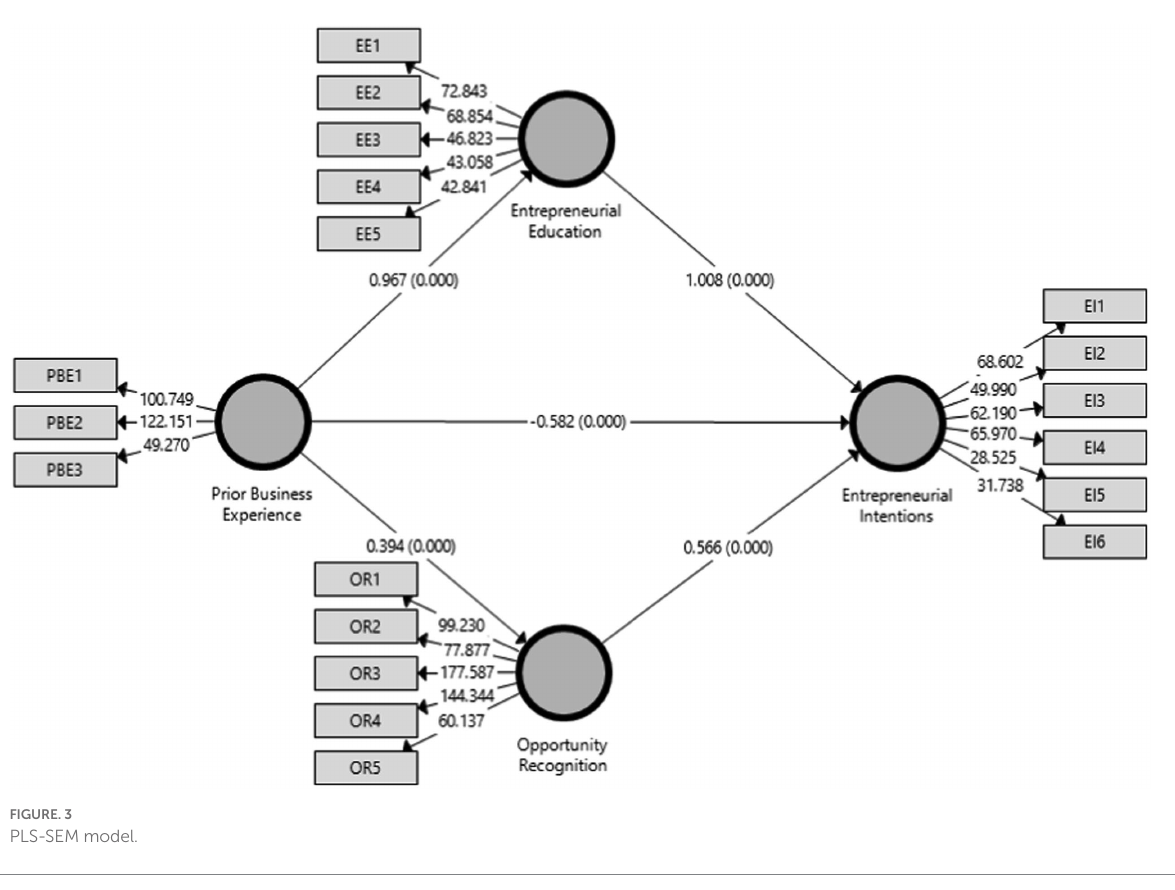
FIGURE. 3 PLS-SEM model.